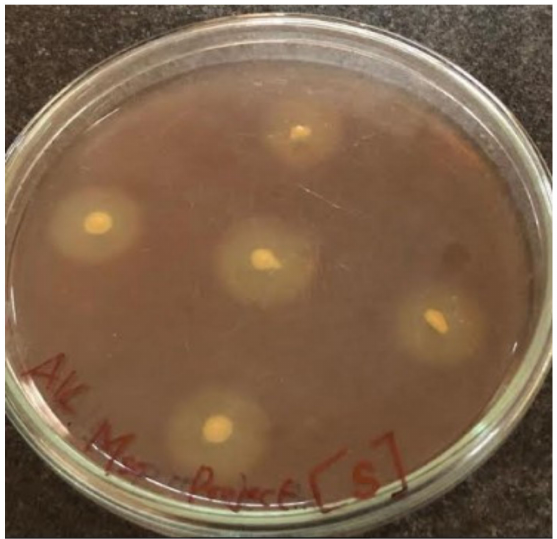
Figure 1. Bacterial isolate showing zone of hydrolysis after iodine solution application.